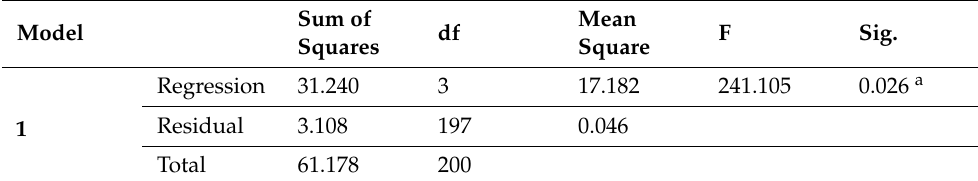
Table 6. ANOVA analysis.